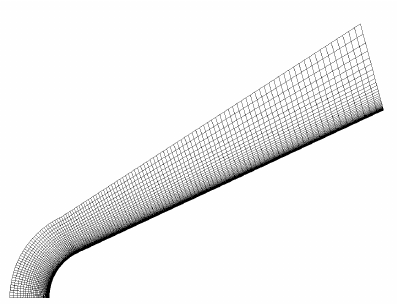
Figure 1. Mesh for the blunted cone (each 5th line is represented in each